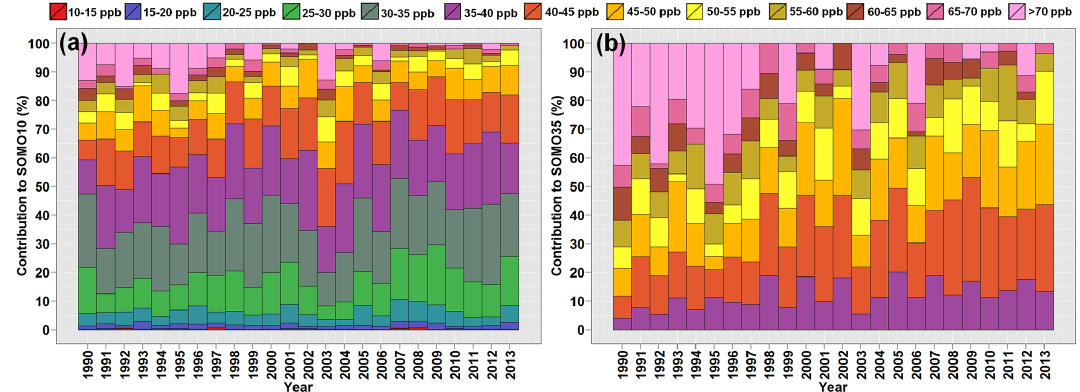
Figure 5. Relative annual contributions to (a) SOMO10 and (b) SOMO35 at Harwell from different O 3 concentration bins. Concentrations are separated into 13 5ppb bins spanning daily maximum 8h mean O 3 concentrations between 10 and >70ppb. Note: these concentration bins are contributing to a decreasing long-term trend in SOMO35 and to a constant trend in SOMO10, as illustrated in Fig. 3.